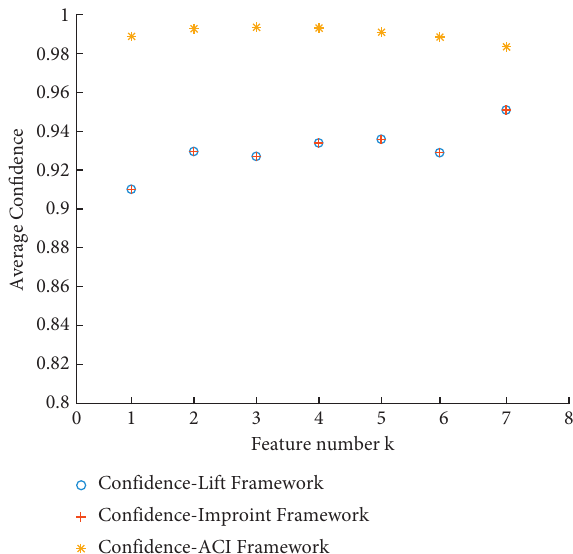
Figure 23: Average confidence of different fault diagnosis rule discriminant criterion.